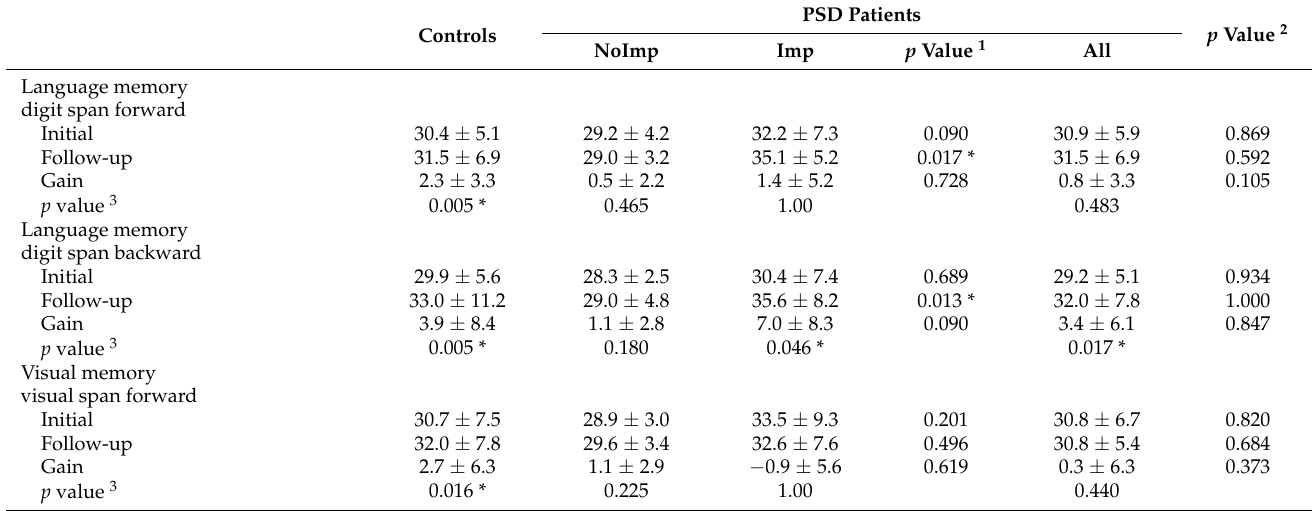
Table 4. Initial and follow-up results of subtests of the CNT for controls and PSD